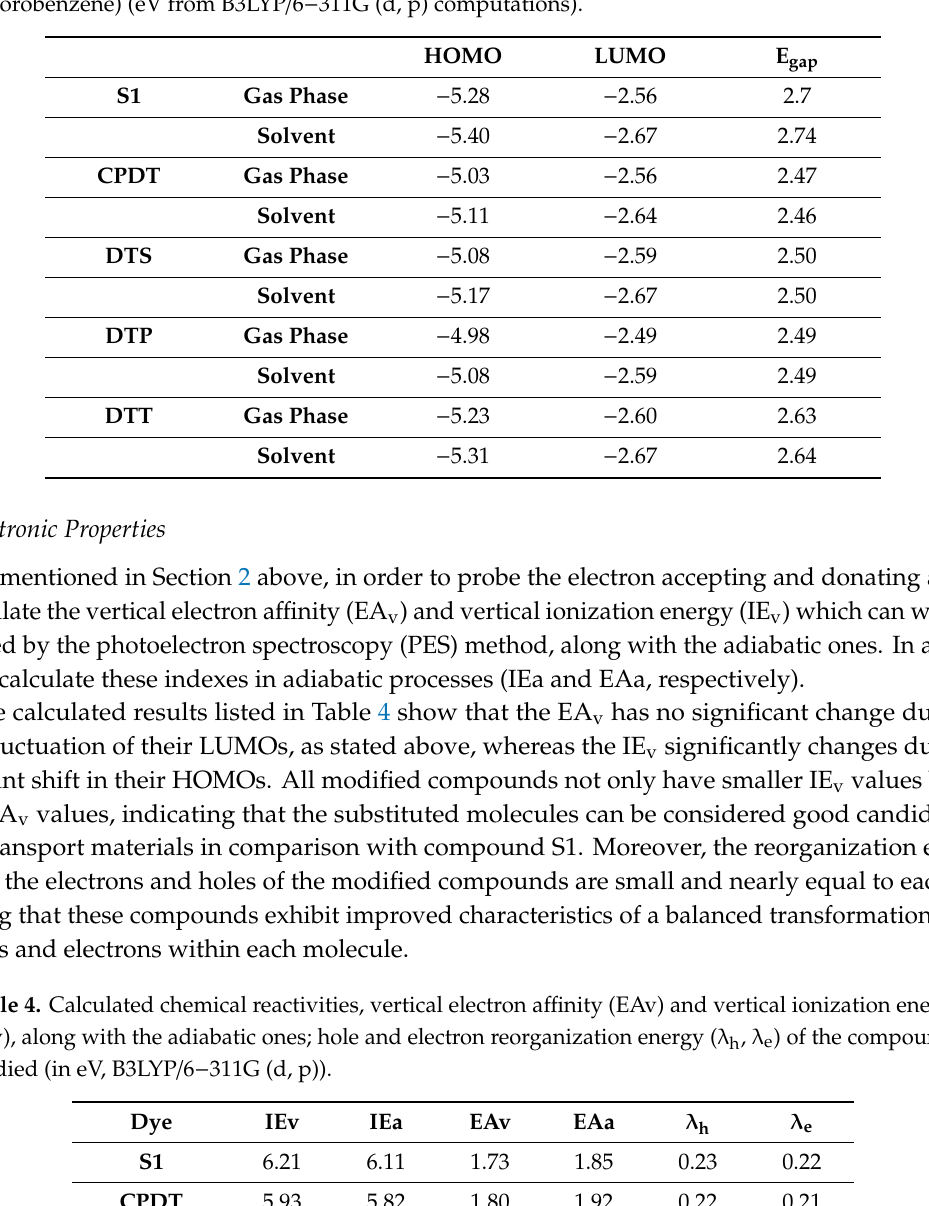
Table 3. HOMO and LUMO energy levels of compounds considered in the gas phase and solvent (chlorobenzene) (eV from B3LYP / 6 − 311G (d, p) computations).